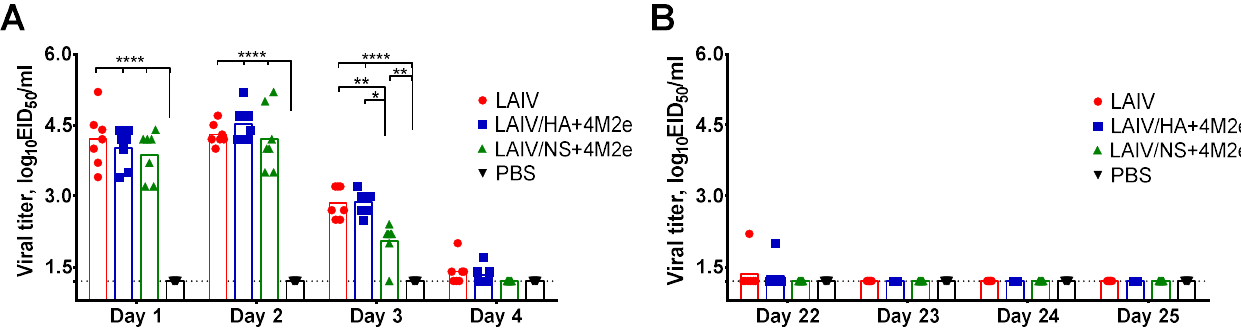
Figure 4. Shedding of LAIV viruses after intranasal immunization of ferrets. Groups of seven animals were inoculated i.n. with indicated viruses or placebo (PBS) at a dose of 10 7 EID 50 , in the volume 500 µL. The second dose was administered 21 days later. Shedding of LAIV viruses was determined by titration in eggs of nasal wash samples collected during 4 days after the first ( A ) and the second ( B ) vaccinations. Data were analyzed by two-way ANOVA with Tukey’s post-hoc multiple analyses test. * p < 0.05; ** p < 0.01; **** p < 0.0001.